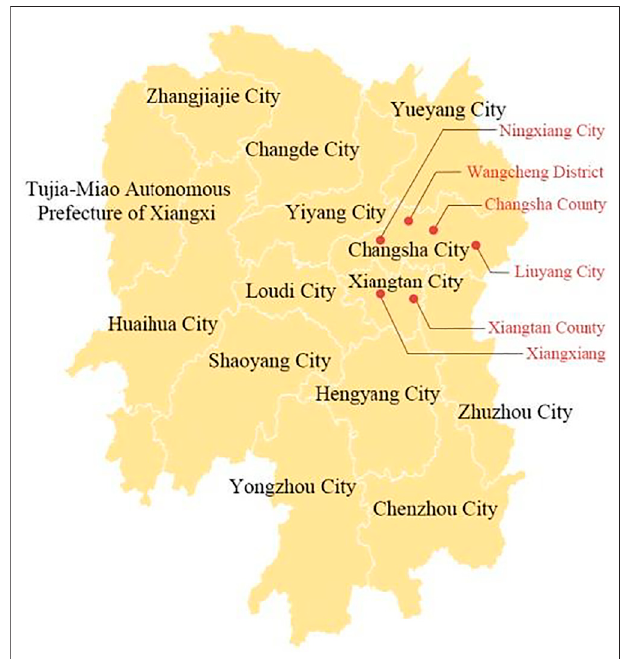
FIGURE 1 | Schematic diagram of areas